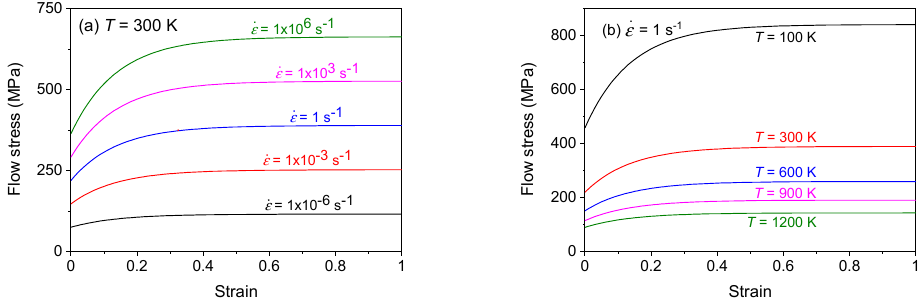
Figure 20. Flow stress–strain curves predicted for A508 steel using the TBRI model ( a ) at 300 K for different strain rates and ( b ) at 𝜀(cid:4662) = 1 for different temperatures. Both diagrams were obtained when m = 1.